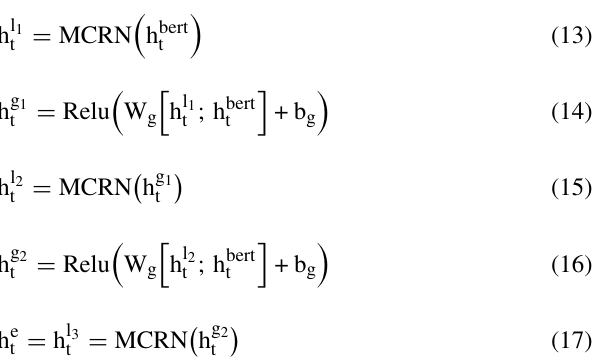
with three computational layers (hops) is exhibited in Fig.